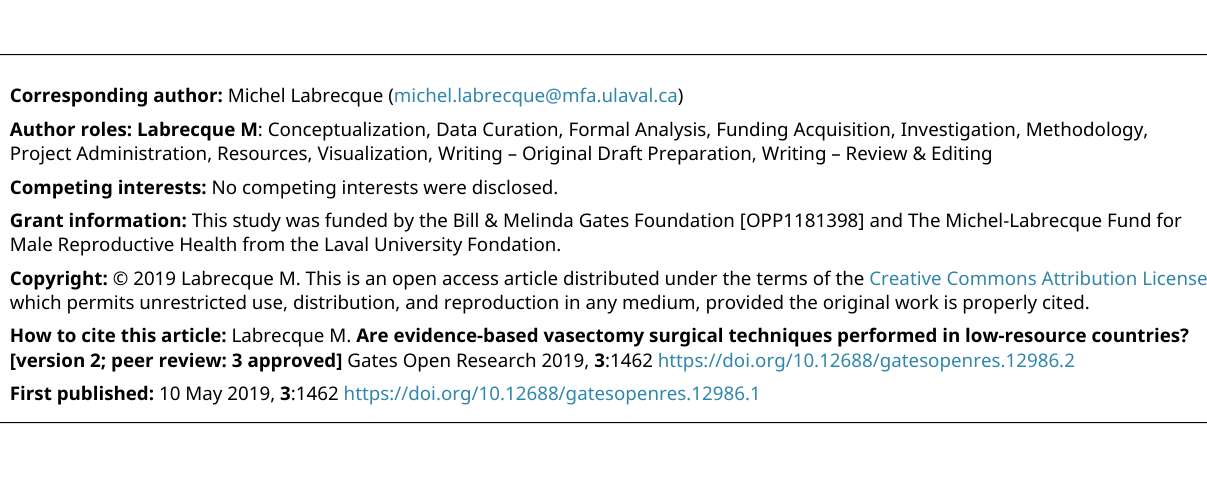
Male Sterilization, Surgical Procedure, Vasectomy, Family